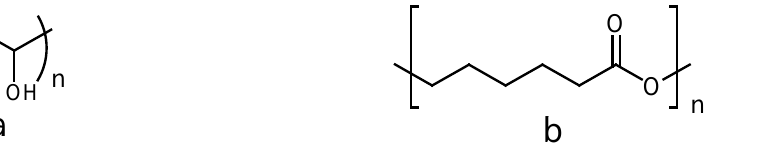
Figure 3. Chemical structures of synthetic polymers ( a ) poly (vinyl alcohol) and ( b ) poly (ε -capro-